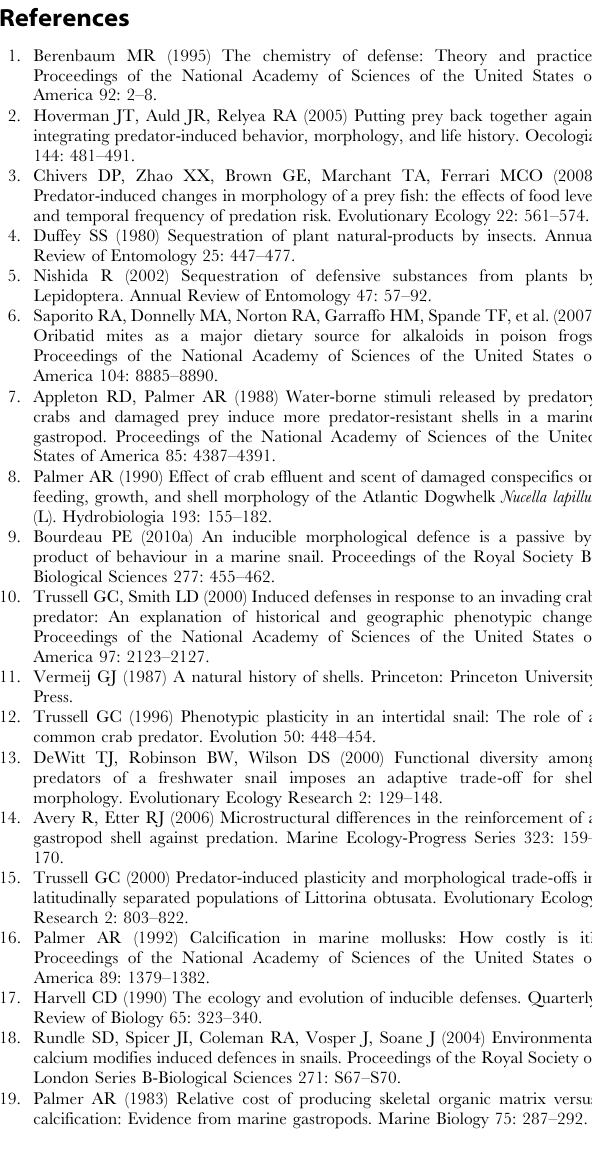
(N = 25), and RM (N =31). Fox J (2003) Effect displays in R for generalized linear models. Journal of Statistical Software 8: 1–27. Table S5 Average stable isotope ratios for C ( d 13 C) and N ( d 15 N) (with standard deviation) measured in water lily tissue, substrate and snail tissue from ten sites in Cuatro Cie´negas, Mexico. Abbreviations as in Table S3. N= 3 in all cases. Table S6 Mean and standard deviation for Calcium (Ca) and phosphorus (P) concentration (ppm), and population fish density (individuals/m 2 ) in sampled rivers and pools in Cuatro Cie´negas, Mexico. Abbrevia- tions as in Table S3 in addition to Pozas Azules (PA). N= 3 in all cases for Ca and P. N=4 in all cases for fish densities except RM, TB, JS (N = 8) and LR (N = 6). Table S7 Competing linear regression models ranked by AIC scores. Variables included in the models: calcium (Ca)